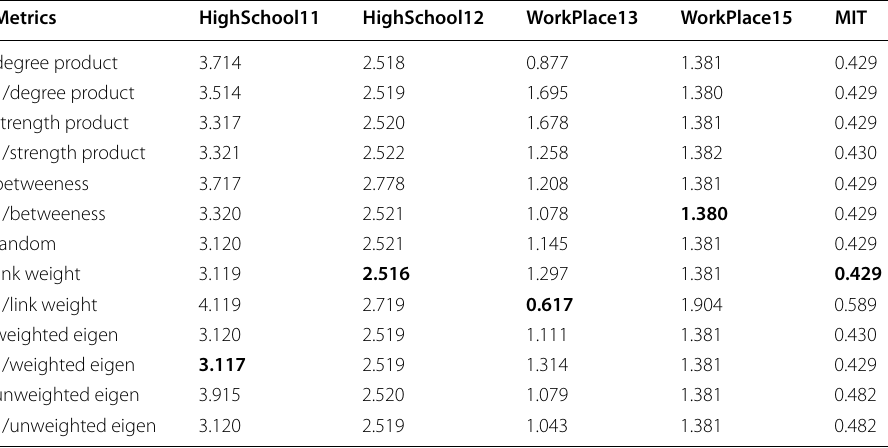
Table 11 The peak time in units of t / T before the maximum prevalence is achieved. The recovery rate is 10% per day, and φ = 10% of the contacts are removed from each temporal network using removal probability